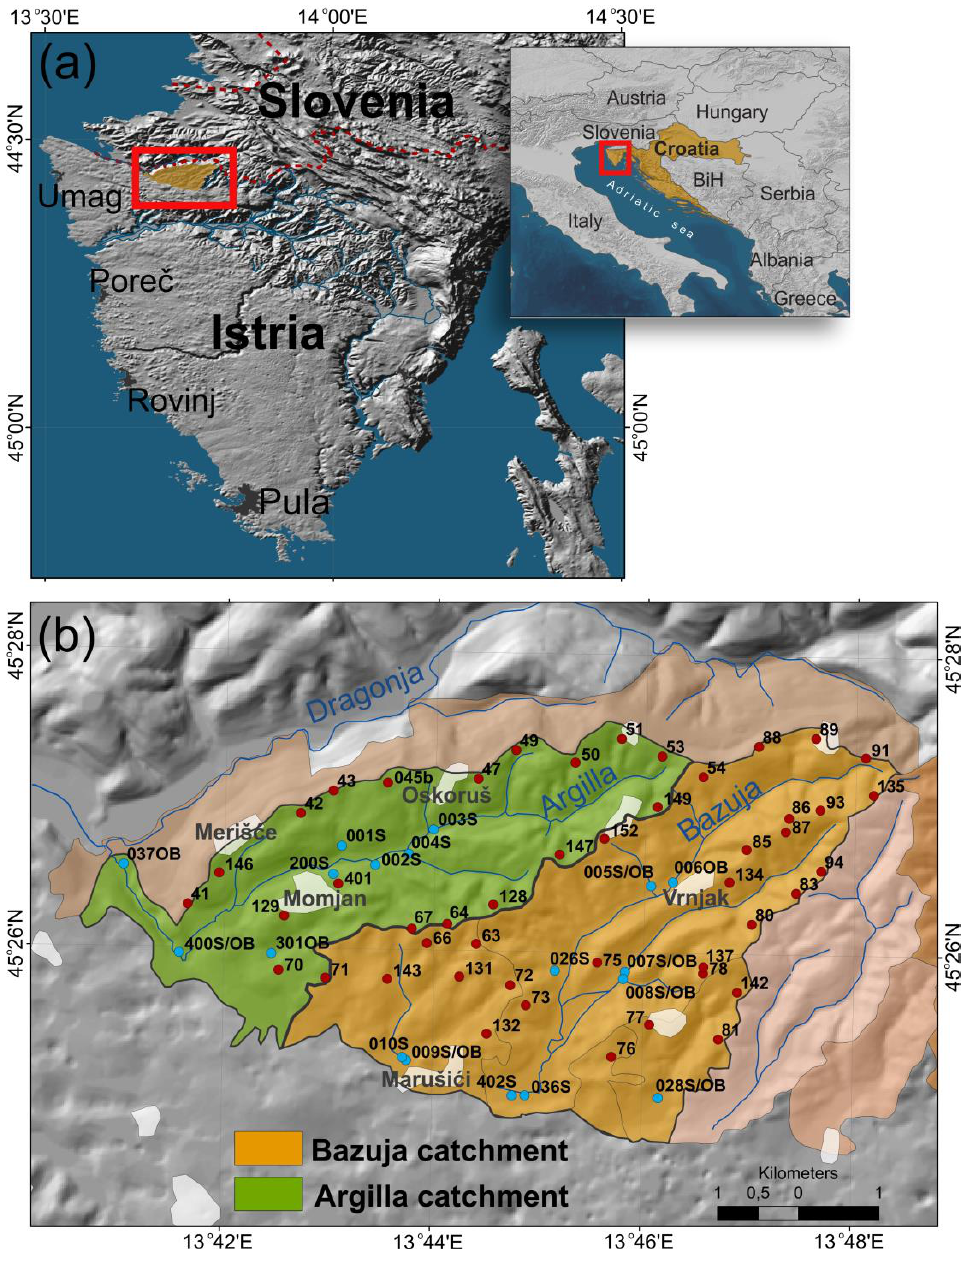
Figure 1. ( a ) General location of the study area; ( b ) rivers Argilla and Bazuja, with their catchments and marked sampling sites of soil profiles (red circles) and stream sediments, overbank sediments, and water (blue